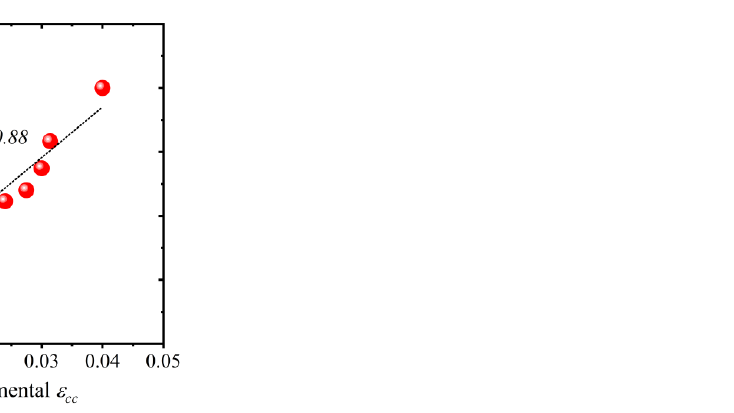
(4) Figure 16. Comparison of experimental vs. predicted compressive strength of hemp-confined con- crete. 5.2. Ultimate Compressive Strain 𝜖 𝑐𝑐 Existing confinement models were also unable to accurately predict the ultimate compressive strain of HFRP-confined concrete. Therefore, Equation (5) was proposed for the ultimate compressive strain of HFRP-confined concrete. The 𝑅 2 value associated with Equation (5) was 0.88, as shown in Figure 17.